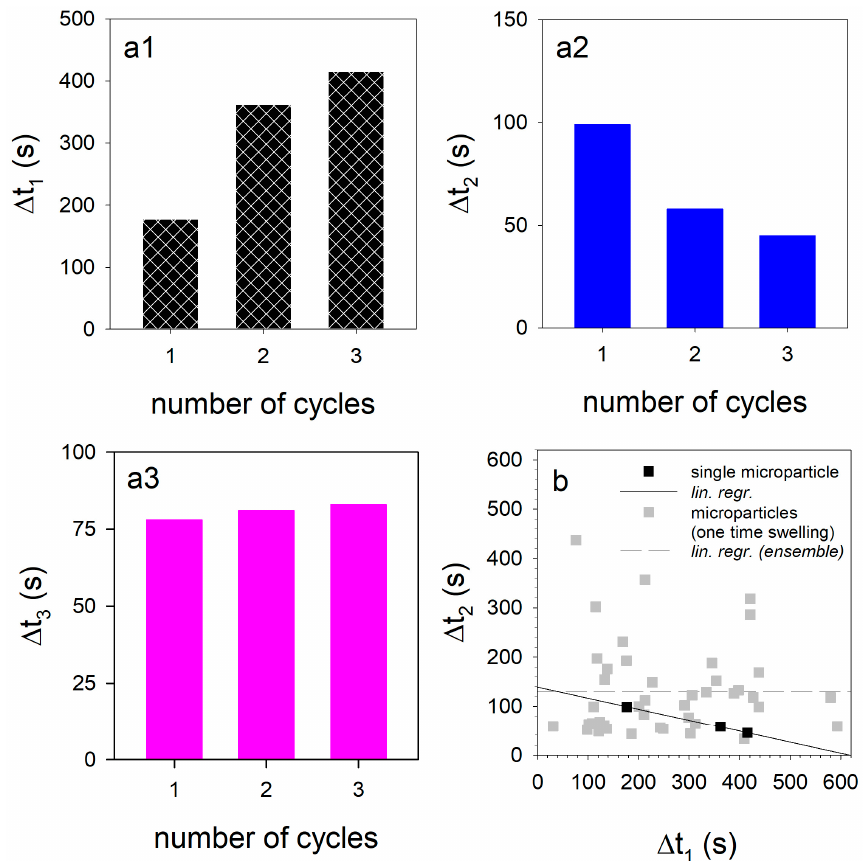
Figure 7. ( a1 − a3 ): Variation of the pulse durations of the individual swelling steps from cycle to cycle. ( b ) Scatter plot demonstrating the relationship between the durations of the two swelling steps.